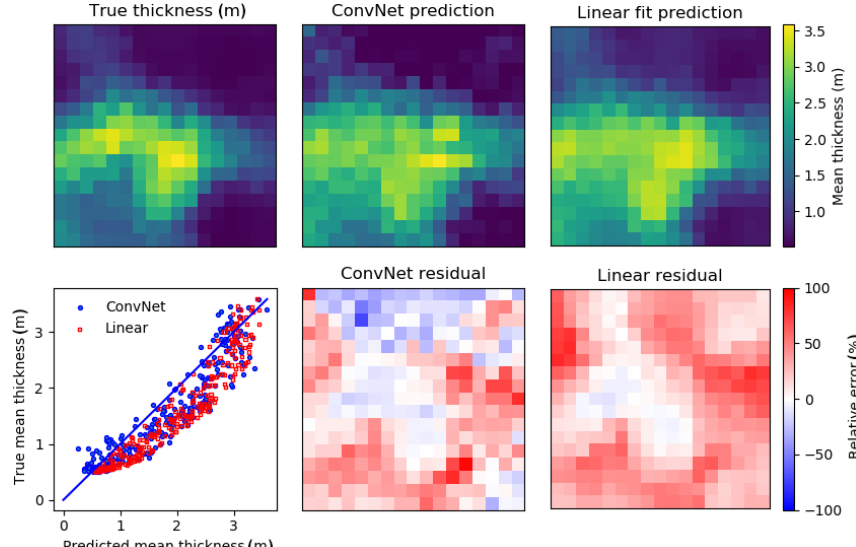
Figure 9. Ice thickness profile of the test set (PIP8), using the linear fit ( T = c 1 F + c 0 ) and ConvNet model, both performed with PIP4, PIP7 and PIP9 as inputs. The input windows are 20m × 20m, with a stride of 5m in each direction, so there is a considerable oversampling. The mean residual for the linear model (35cm) is much higher than for the ConvNet (19cm), which means the resulting mean thickness has almost twice the REM (24% vs. 13%). The scatterplot clearly shows the linear model (using 20m windows as well, with coefficients from Table 3) predictions are consistently biased high, which is also apparent in the linear model residual.